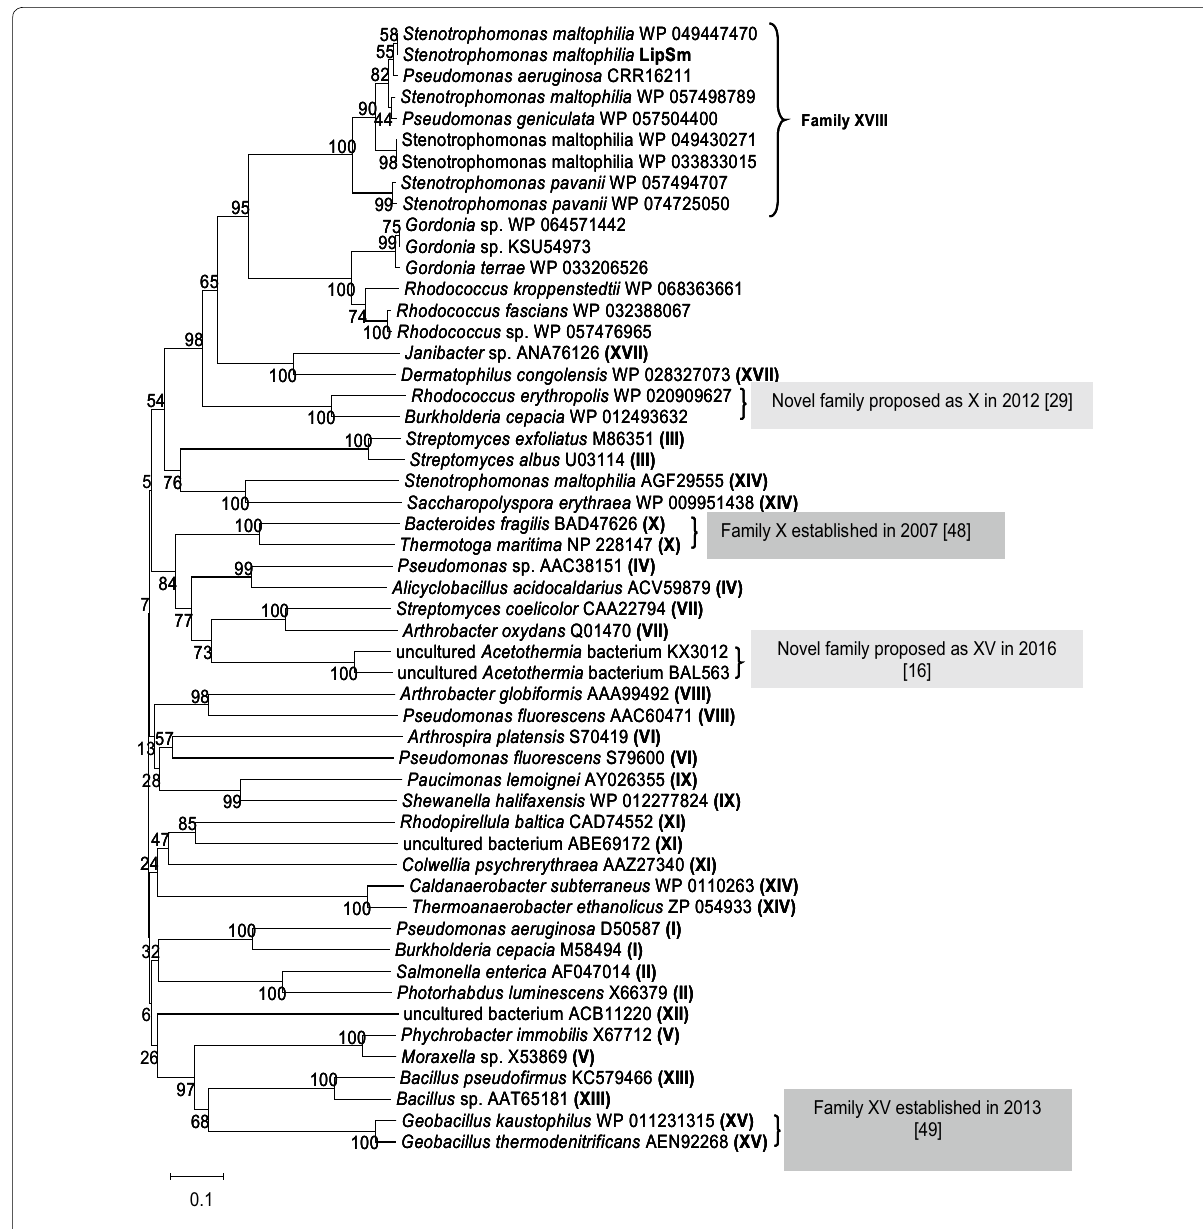
Fig. 2 Phylogenetic dendrogram indicating the position of LipSm as the first characterized member of the novel family XVIII. Latin numbers in parentheses indicate family indexes. Phylogenetic analyses were conducted with algorithm MEGA. The evolutionary history was inferred using the Neighbor‑Joining method. The percentage of replicate trees in which the associated taxa clustered together in the bootstrap test (1000 replicates) are shown next to the branches. Scale bar indicates substitutions per